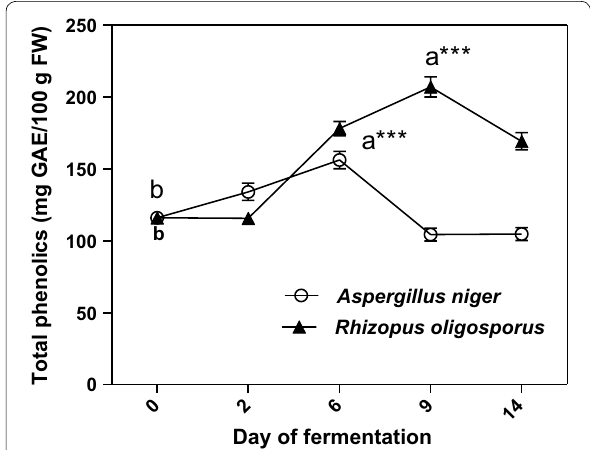
Fig. 1 Total phenolic content of extracts from solid state fermented apricot pomaces. Values are mean SD of triplicate determinations ± and different letters (a, b) indicate significant differences (p < 0.05) (paired t‑test)